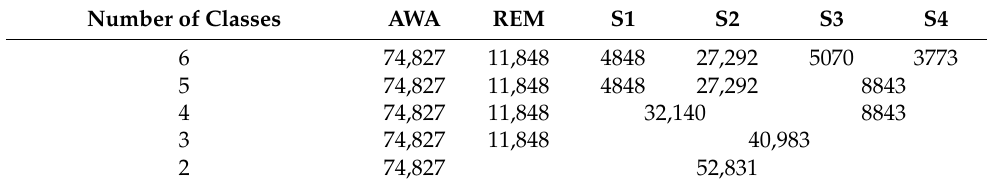
Table 1. Total number of samples in sleep-EDF dataset (R and K criteria).